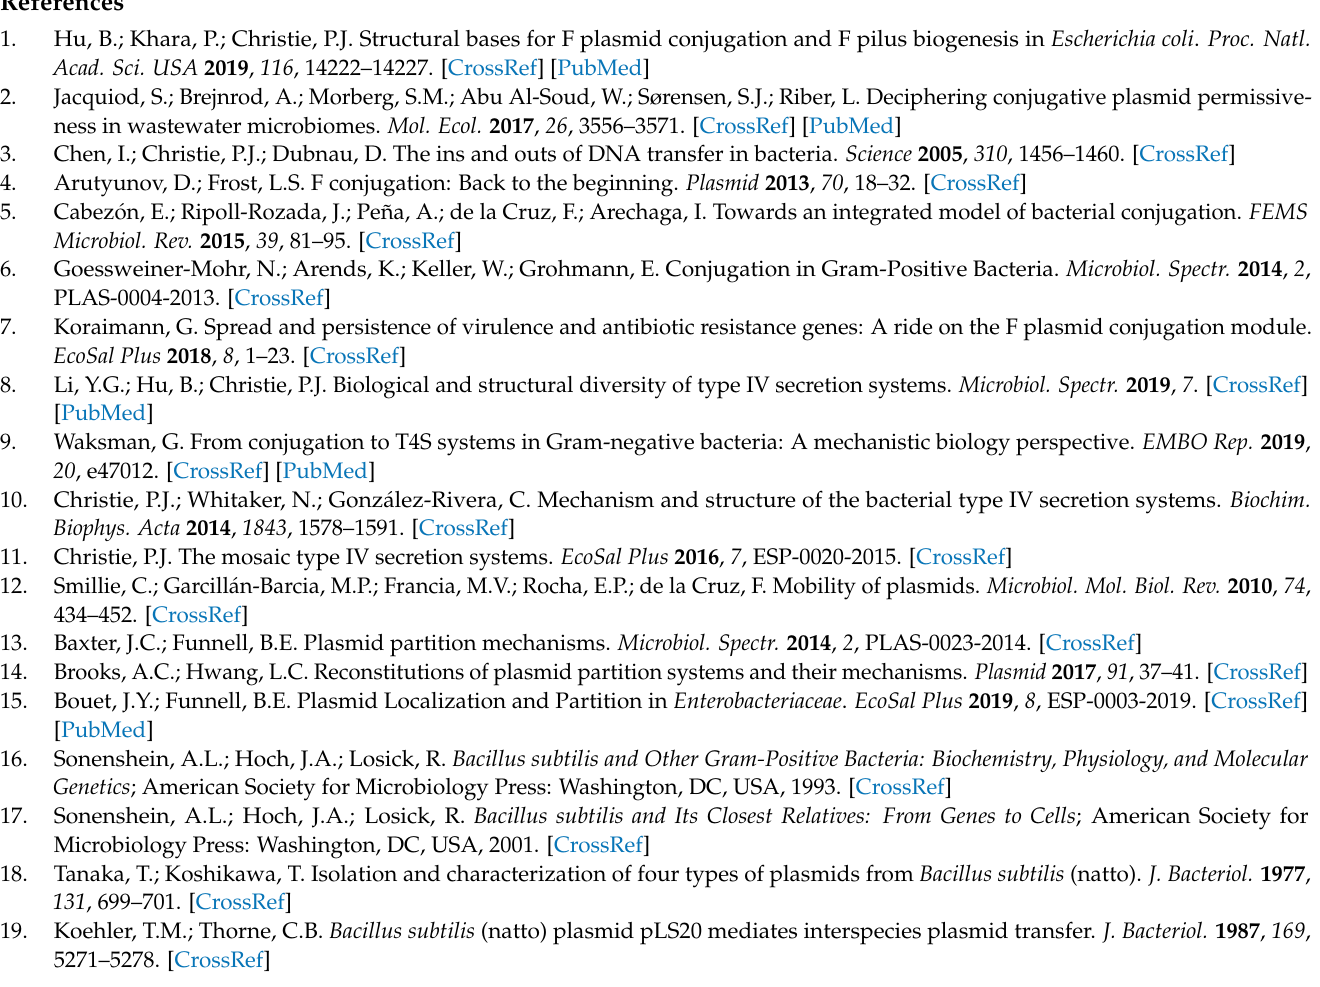
Figure A2. Microscopic observation of cells after mating. KV11 was grown in the presence of IPTG and mixed with KV10 for conjugation. After fixation with formaldehyde, the cells were treated without ( A ) and with ( B ) sonication and examined under a fluorescence microscope. The experiments were repeated three times and the representative results are shown, merging the images of green and red fluorescence of sfGFP and mKATE2 with that of the optical microscope.